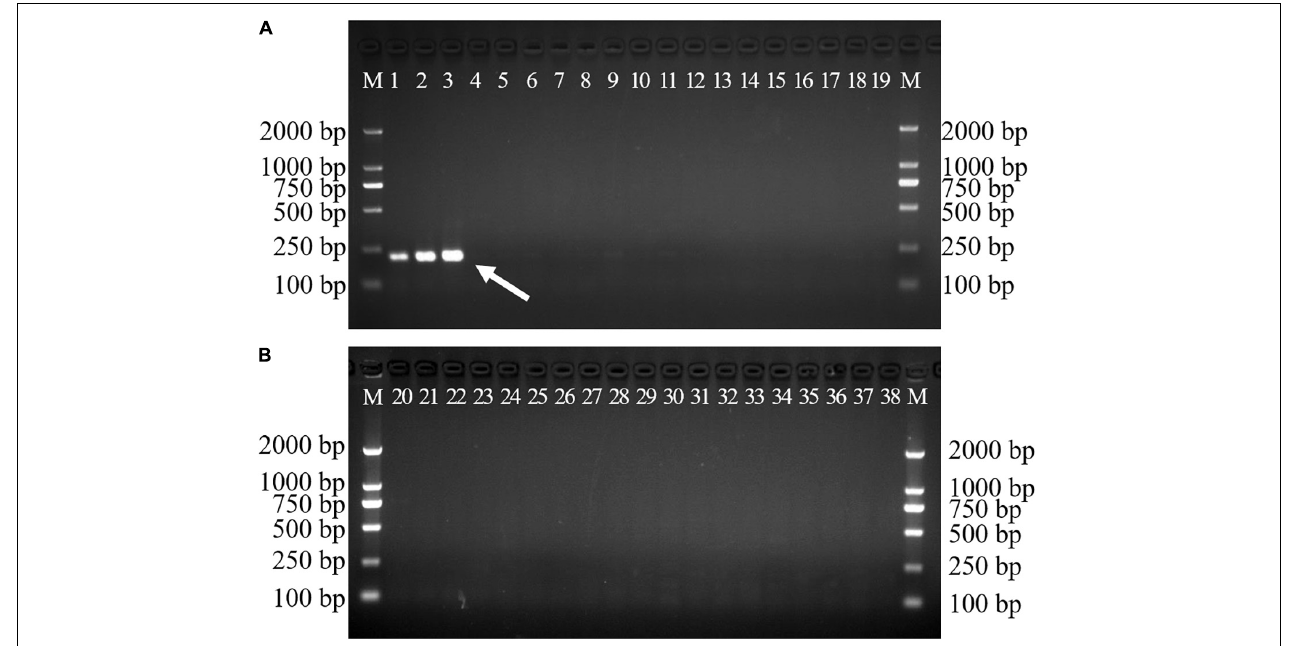
FIGURE 3 | Amplification of the developed SCAR marker SHF/SHR in 38 different Dendrobium species. Two 1.5% agarose gels were used for 38 Dendrobium species electrophoresis analysis (A,B) . Lane 1 ∼ 38: Details of 38 Dendrobium species are provided in Table 1 . Lane M: Trans2K DNA Marker with lengths (bp); Arrowheads represent specific amplified bands in all the D. officinale